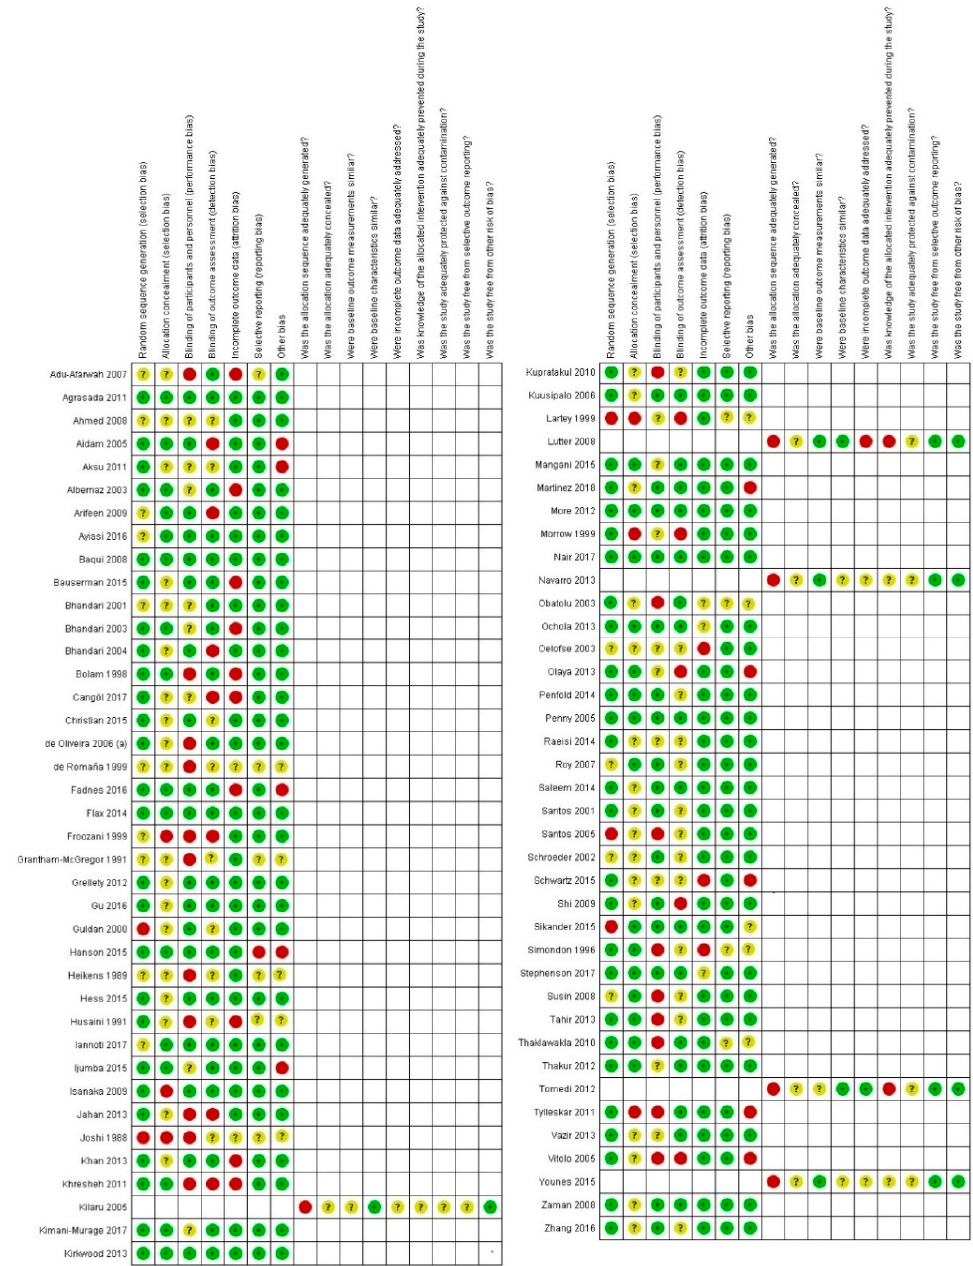
Figure 2. Traffic light plots presenting the risk of bias found in studies. Red circles represent a high risk of bias, green dots represent a low risk of bias and yellow dots represent an unclear risk of bias.